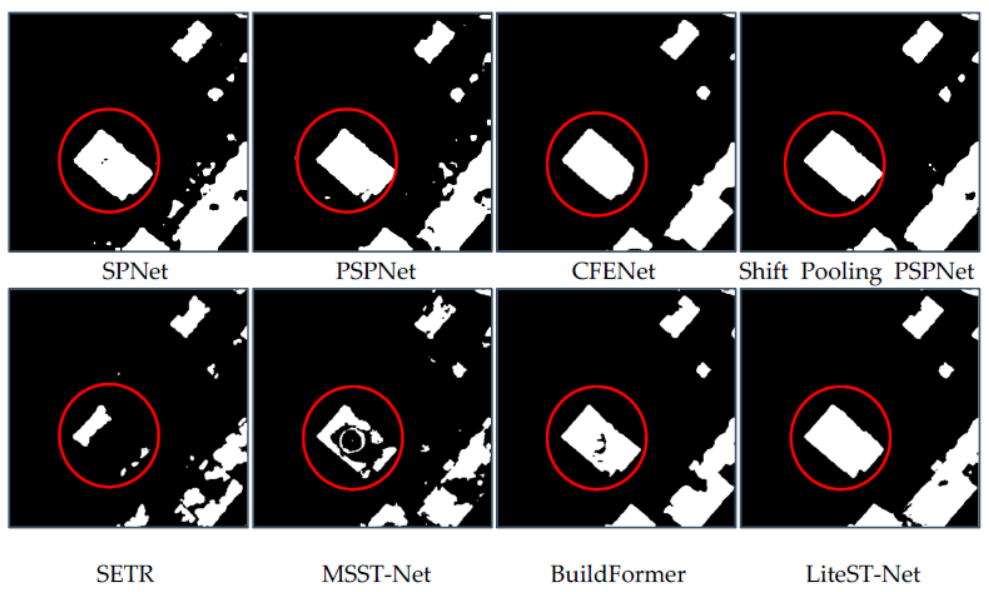
Figure 6. Prediction of large building on the Massachusetts building test dataset. The red circle shows the predicted results of various models for the same large building.